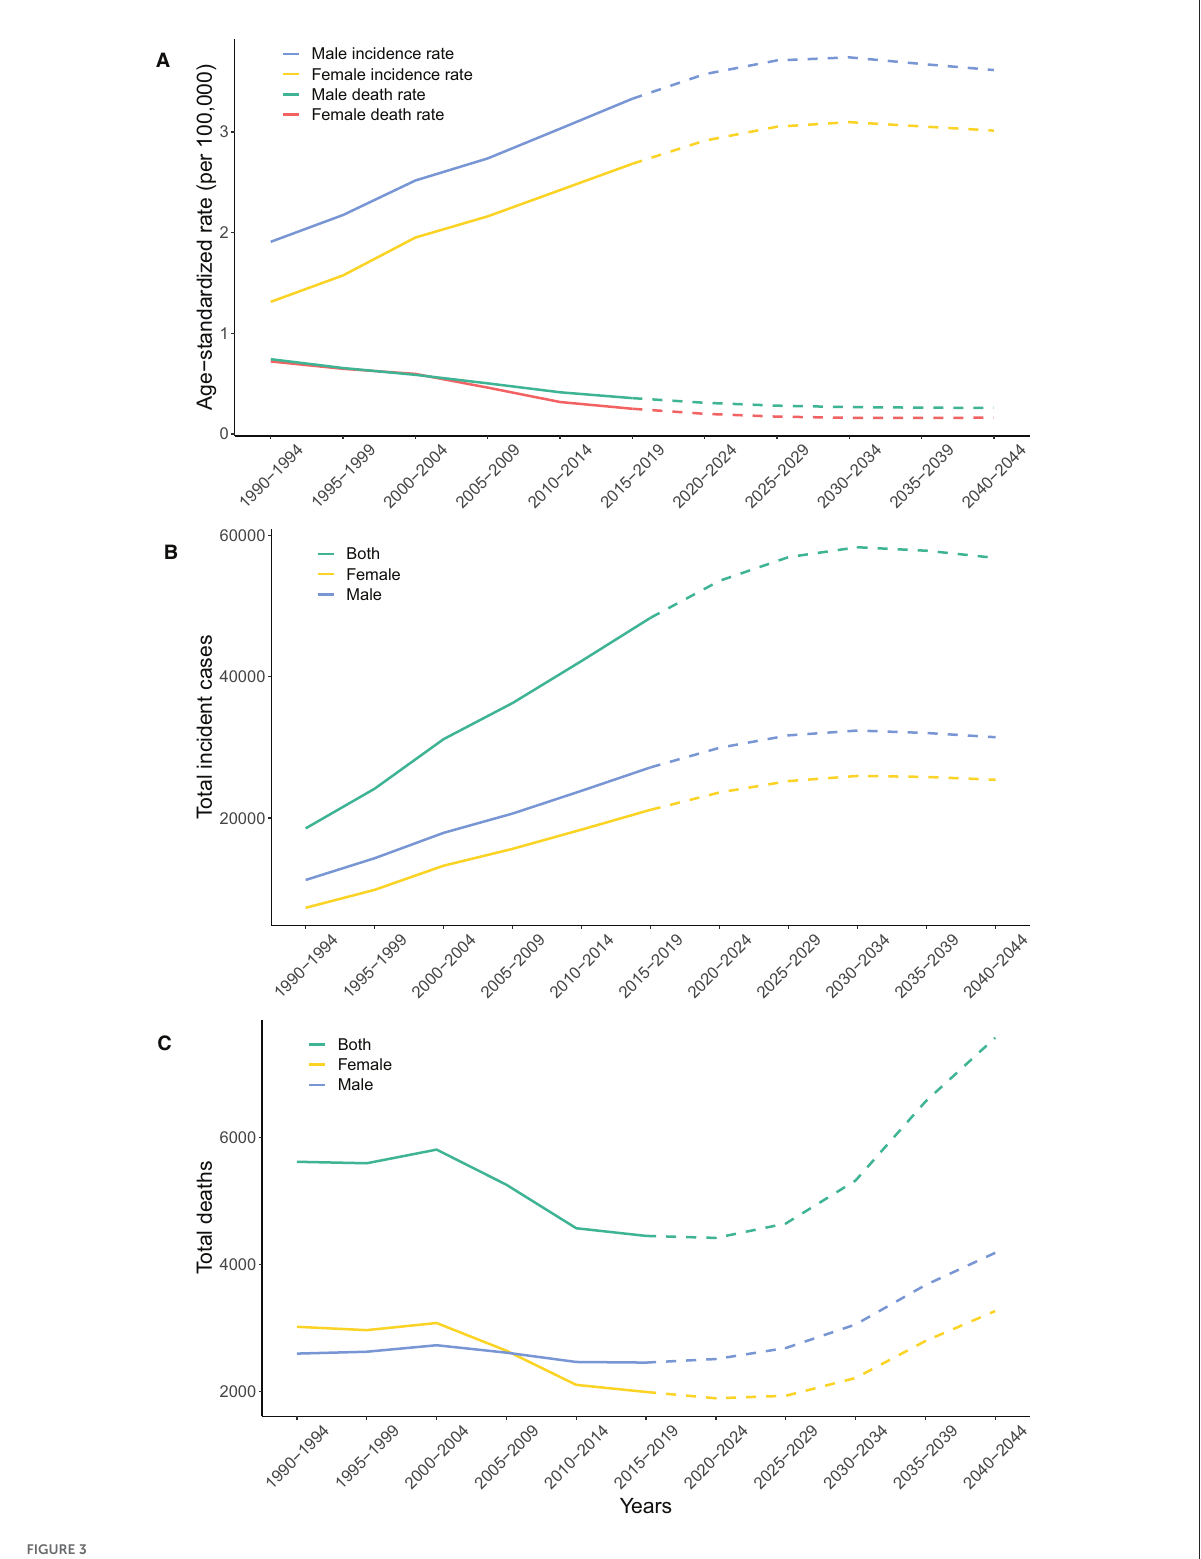
FIGURE3 Observed trends from 1990 to 2019 (solid line) and predictions from 2020 to 2044 (dashed line) in age-standardized rates of incidence and deaths (A) , and the number of incident cases (B) and deaths (C) of IBD by sex in China. IBD, inflammatory bowel disease.